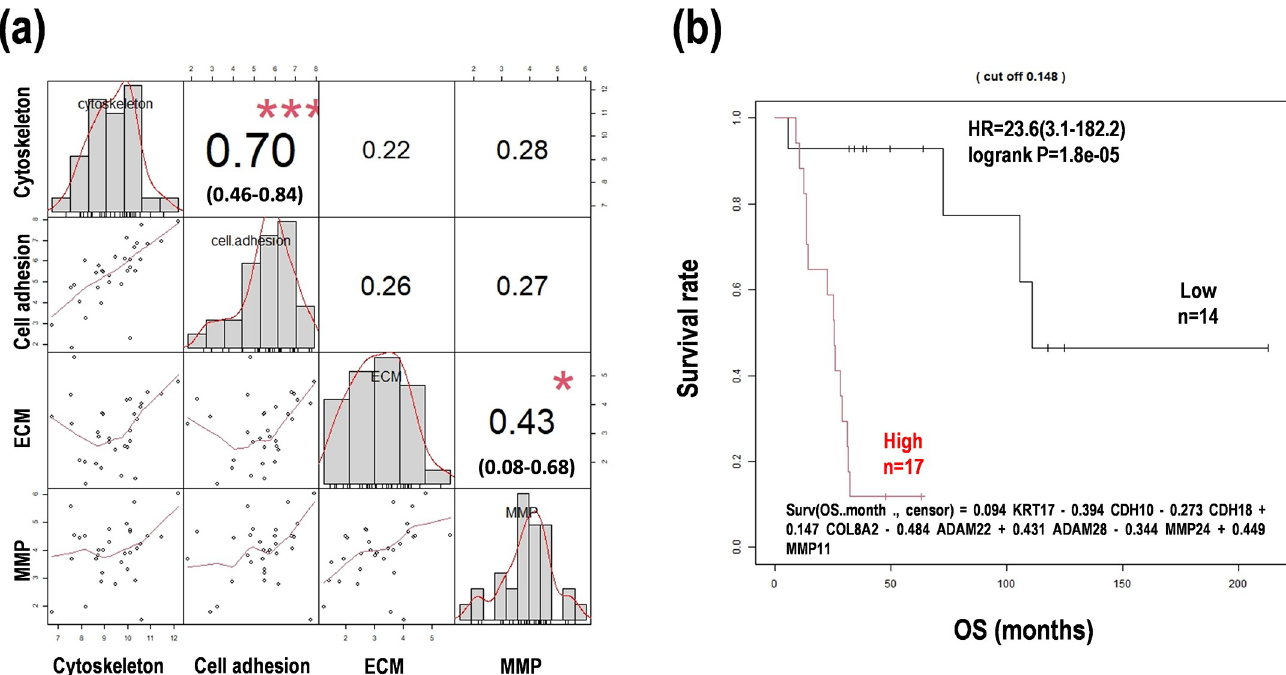
Fig 5. Multiscore-based survival prediction model for the statuses of cancer morphology and microenvironment in PCNSL. ( a ) Status score correlation with Pearson correlation coefficient among the statuses of cytoskeleton, cell adhesion, extracellular matrix (ECM), and matrix metalloprotease (MMP). The 95% CIs are presented in the parentheses. ��� p < 0.01, � p < 0.1 ( b ) The Kaplan-Meier analysis from the multiscore-based survival prediction